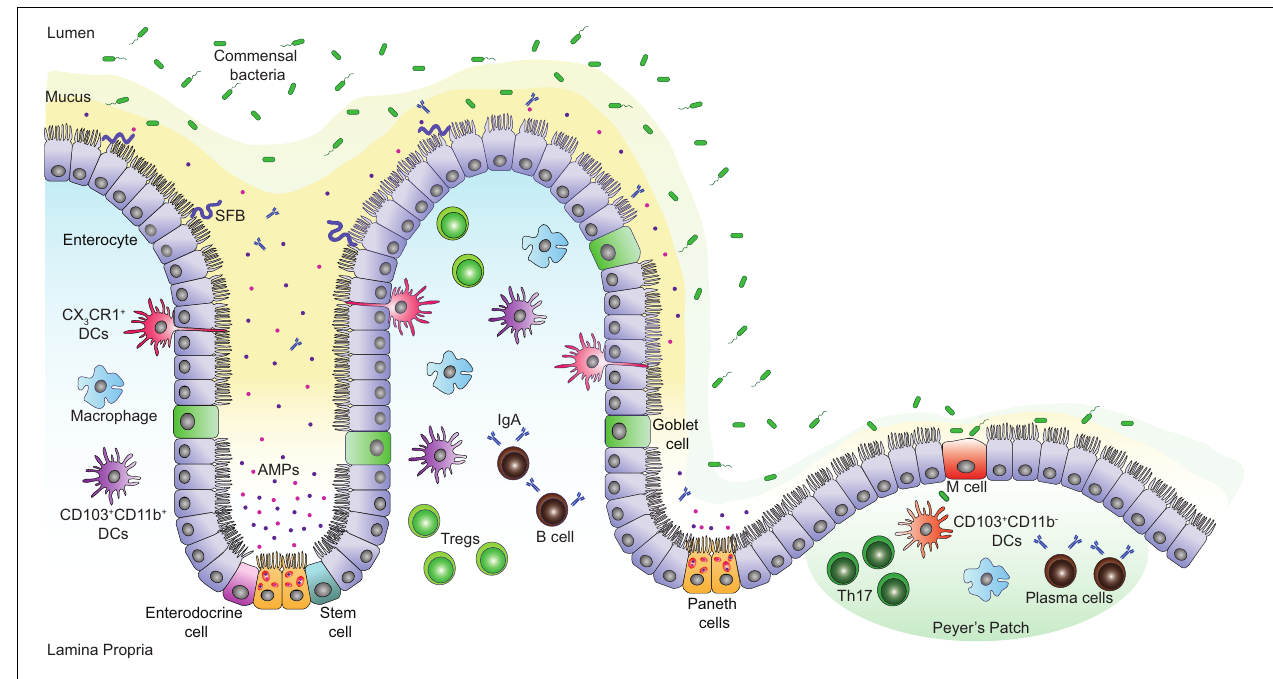
epithelial stem cells that proliferate and give rise to daughter cells.These cells include enterocytes, mucus-producing goblet cells, hormone-producing enteroendocrine cells, AMP-producing Paneth cells at the base of the crypts and finally, M cells that sample antigens from the intestinal lumen in order to present them to nearby immune cells. A high number ofT cells, macrophages, IgA secreting B and plasma cells are present in the lamina propria and the Peyer’s patches. In addition, CD103 + CD11b − and CD103 + CD11b + dendritic cells (DCs) promote the development ofT helper (Th17) andT regulatory (Treg) cells respectively, while CX 3 CR1 + DCs sample the lumen antigenic